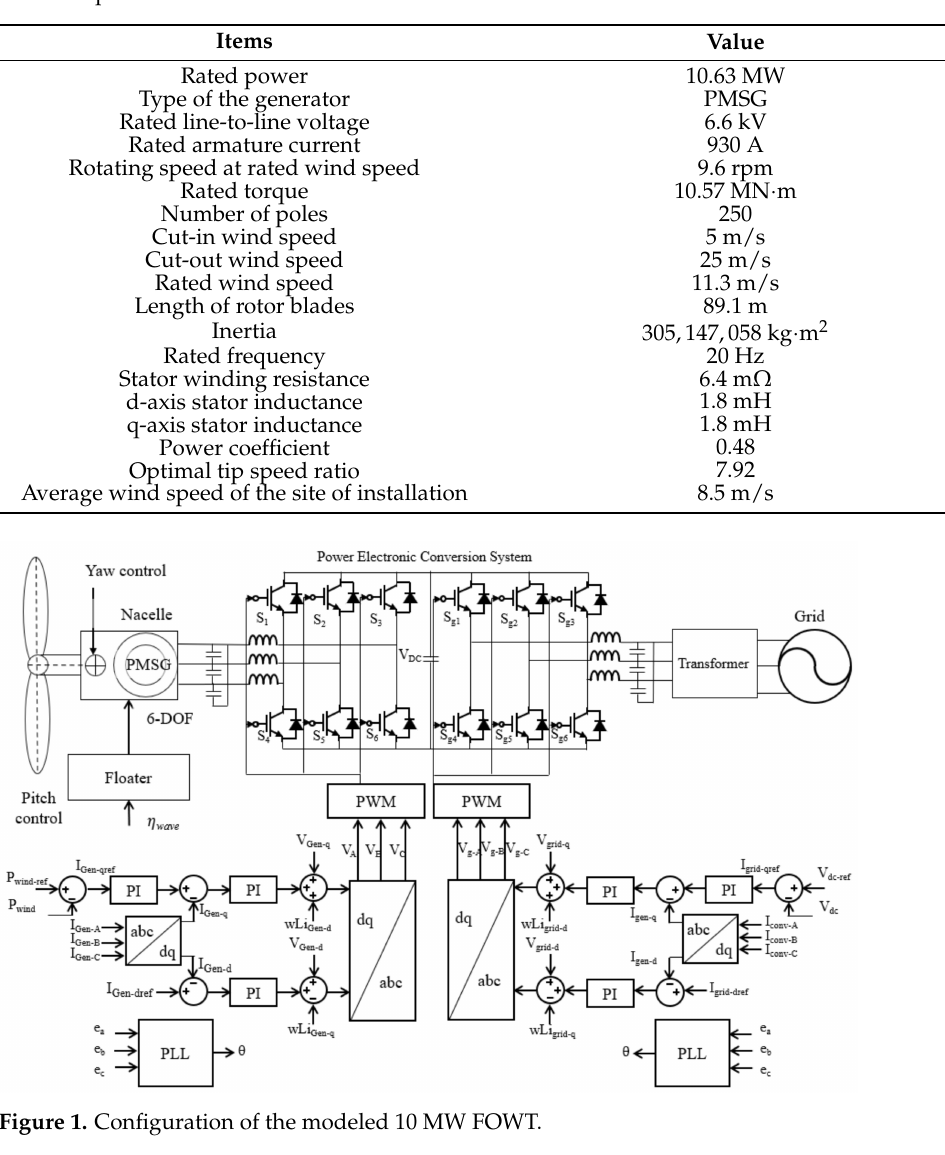
Table 2. Specifications of the 10 MW FOWT.